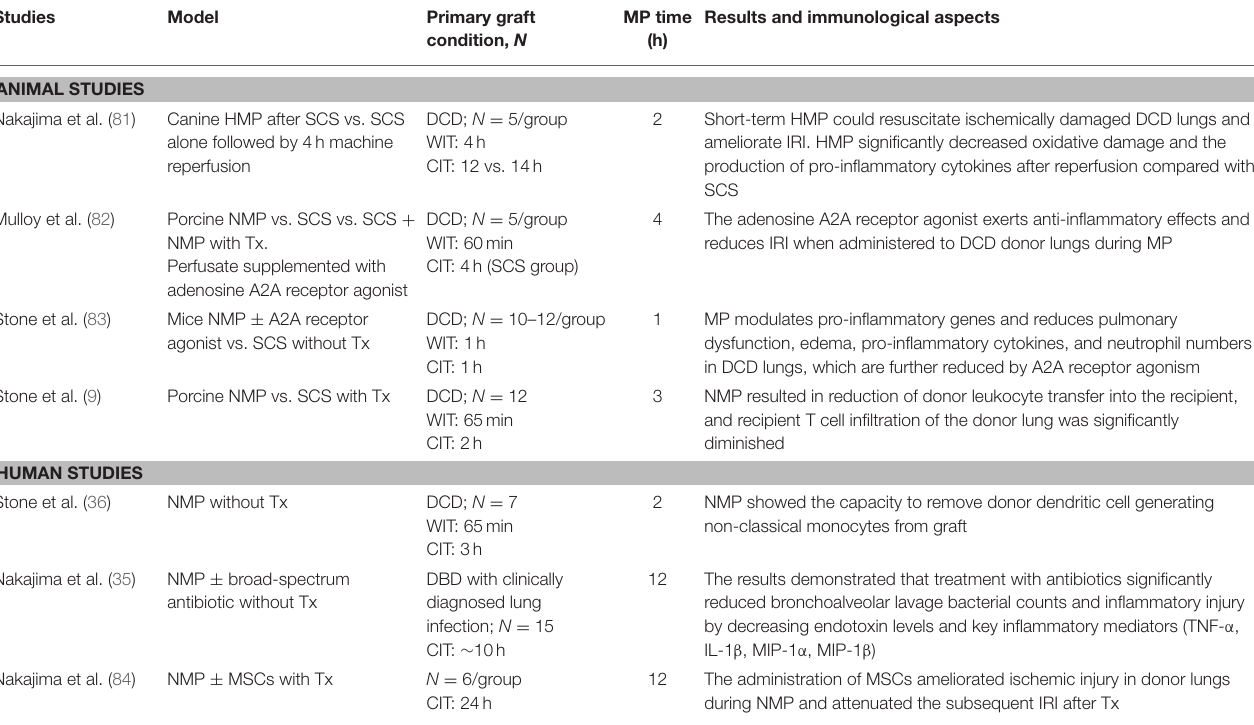
MP time Results and immunological aspects condition, N (h)